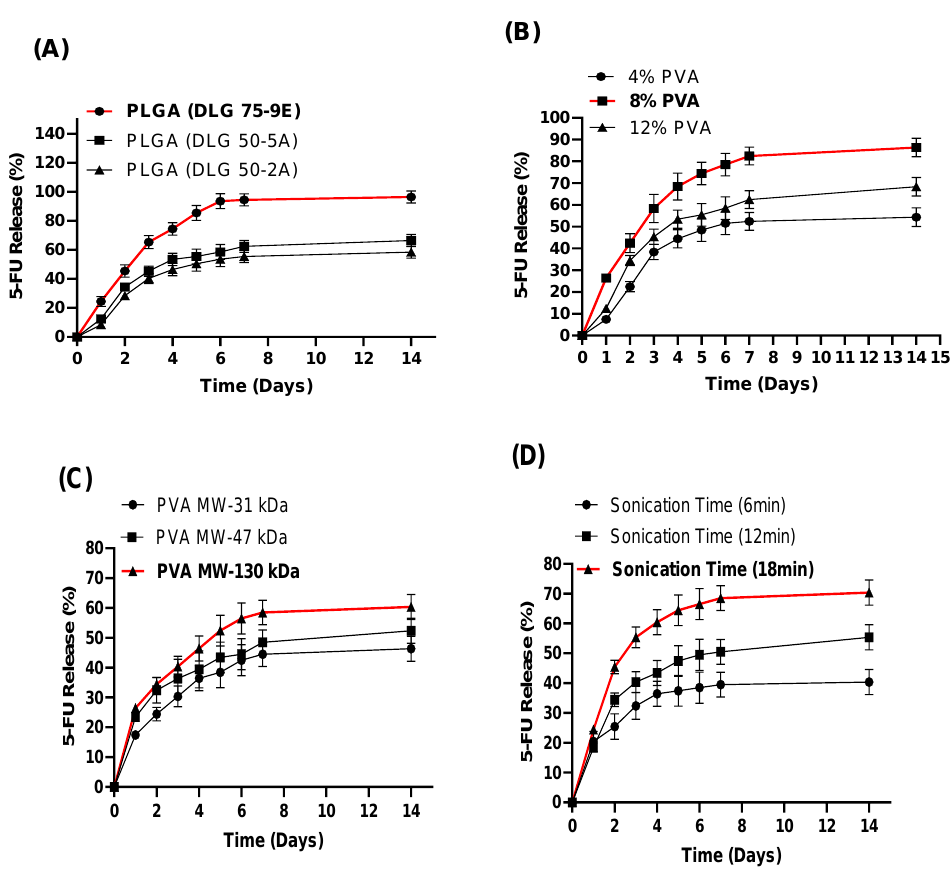
Figure 4. In vitro drug release for the 10 % w/w 5-FU loaded PLGA nanoparticles prepared using different PLGA polymers (A), PVA loadings (B), PVA molecular weights (C), and sonication times